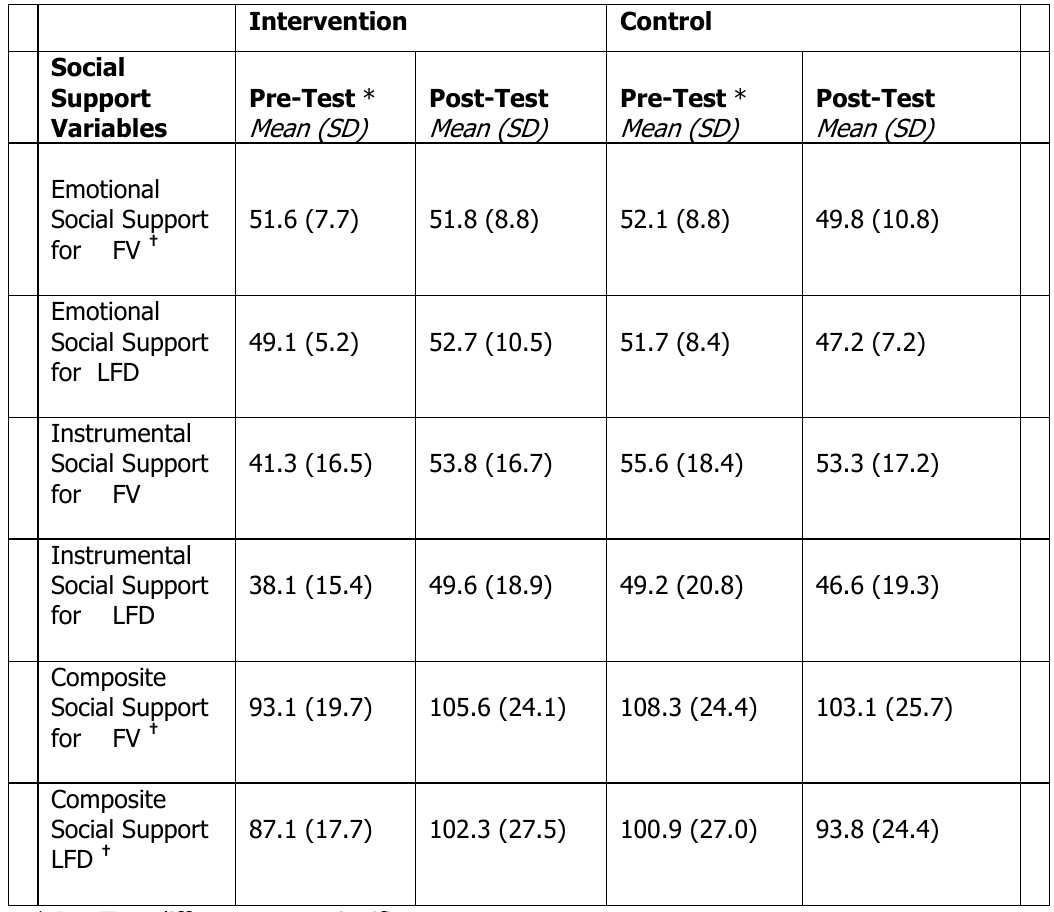
Pre and Post intervention Social Support Scale Scores by Treatment